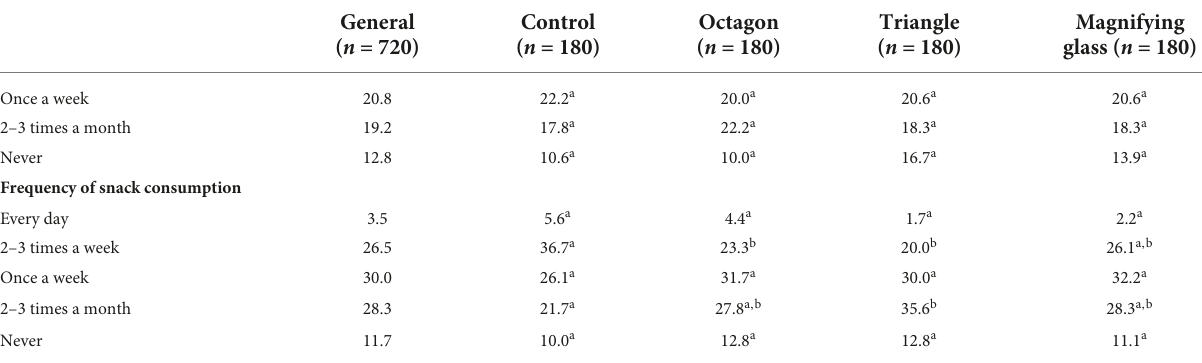
TABLE 3 F values and p -values of fixed effects and interactions of the GLM performed to the understanding of nutritional information and the ANOVA models used for healthfulness perception and purchase